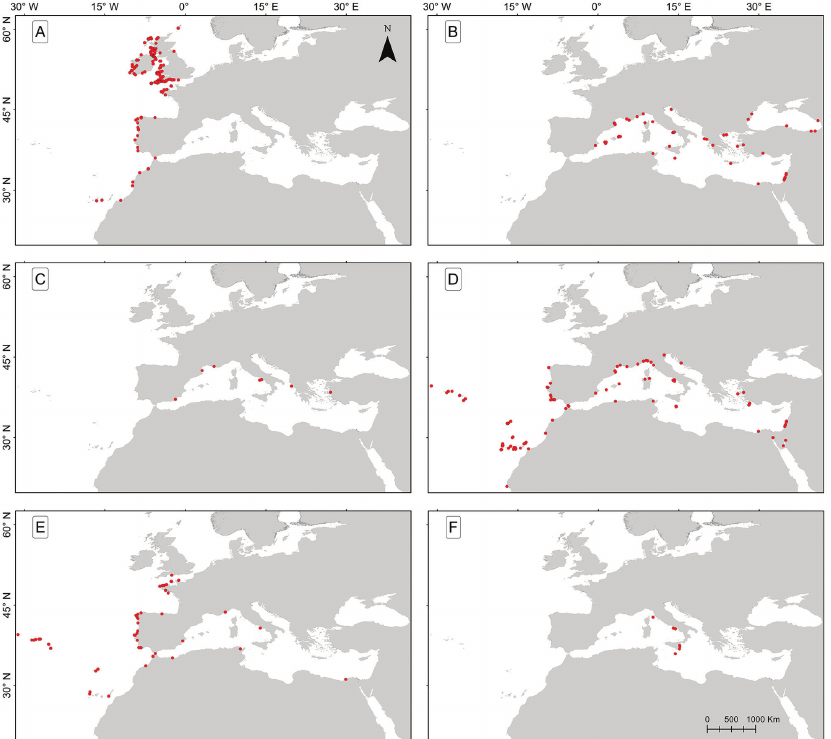
Figure 5. Distribution of Dynamene species along the NE Atlantic-Black Sea axis based on